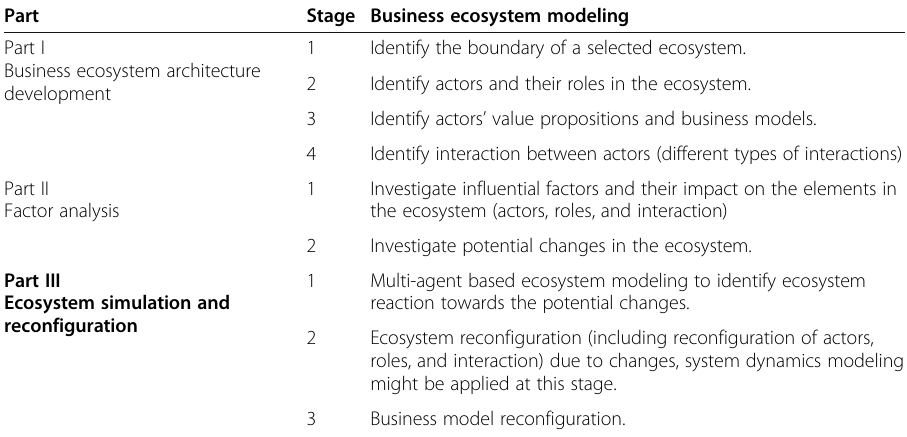
Table 1 Business ecosystem modeling process (Ma, 2019) Part Stage Business ecosystem modeling Part I Business ecosystem